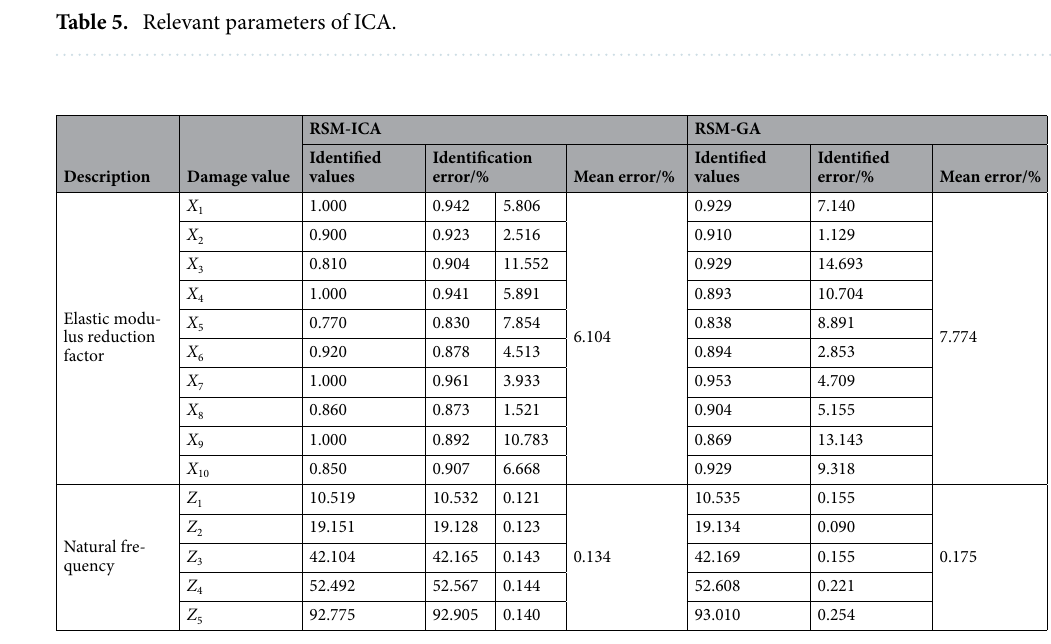
Table 6. Comparison of damage identification results. Identification error = (damage value – identified value)/ damage value ×